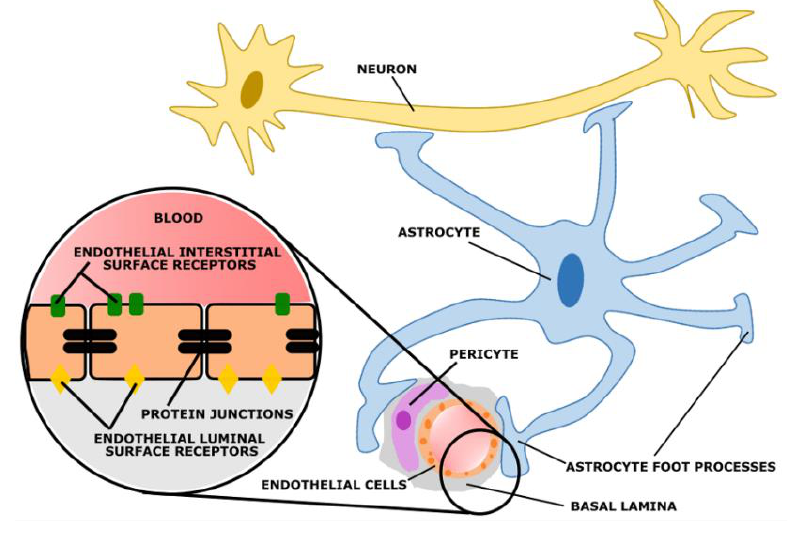
Figure 35. The NVU, highlighting the BBB.